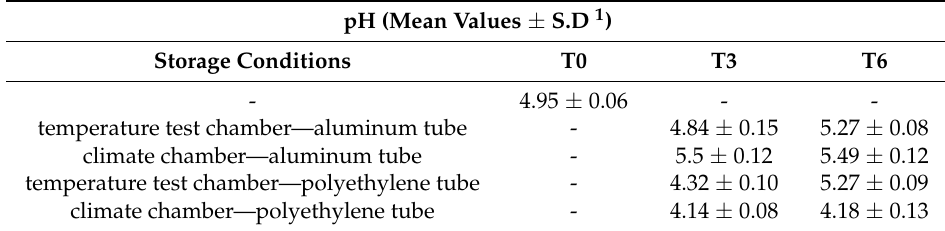
Table 1. pH of hydrogel-based formulation in different storage conditions.